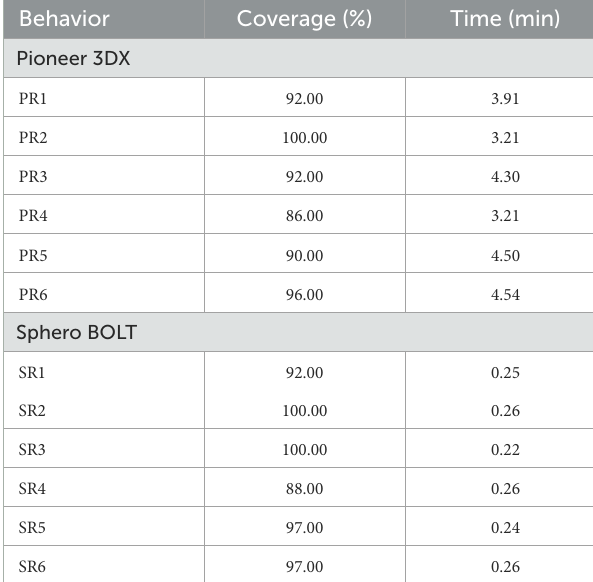
TABLE 4 Coverage performance of tuned collective behaviors from Figure